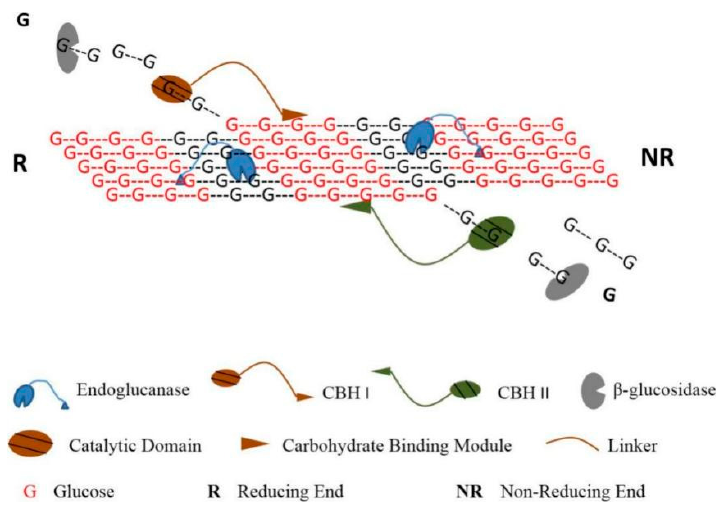
Figure 3. The action of various cellulases enzymes on surface layer of cellulose [21].